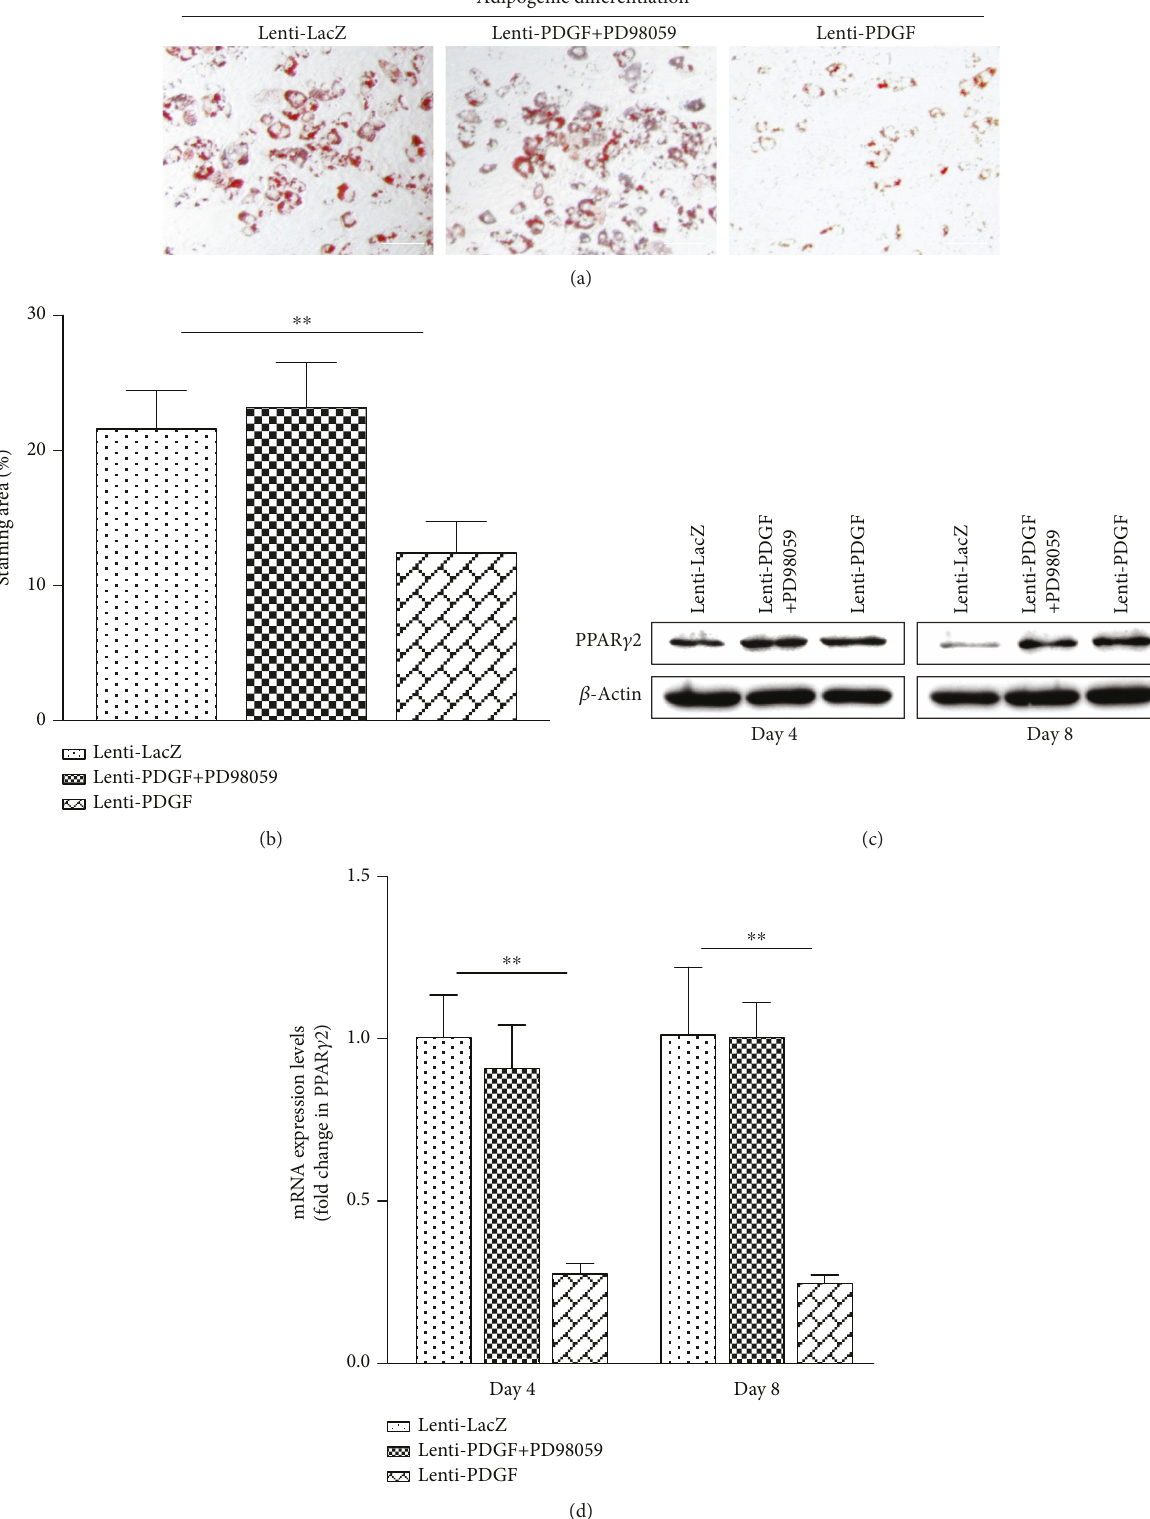
Figure 3: PDGF-BB inhibited BMSC adipogenic di ff erentiation via ERK1/2 signaling pathways. (a) Oil Red O staining. (b) Oil Red O positively stained area in each group. (c) PPAR γ 2 protein expression. (d) PPAR γ 2 mRNA expression. ∗∗ P < 0 01 ; scale bar: 100 μ